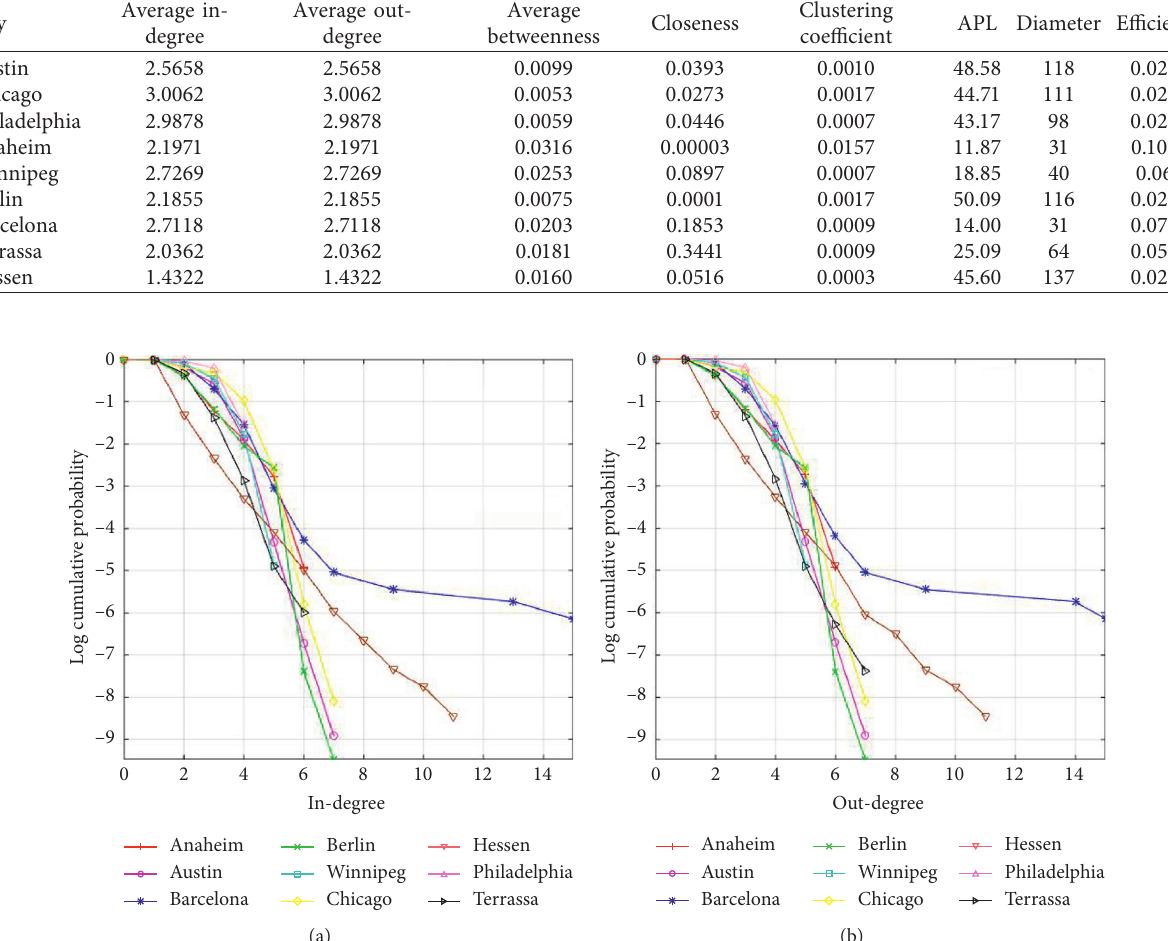
Figure 1: In-degree and out-degree distributions of urban road networks in the log-linear